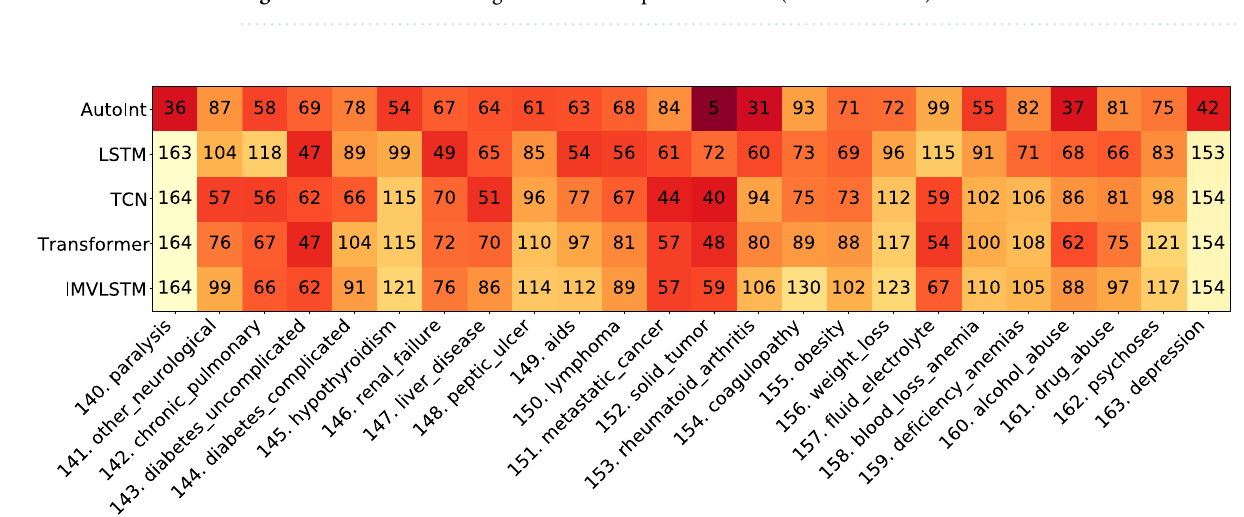
Figure 13. Visualization of global feature importance ranks (feature 112-139).